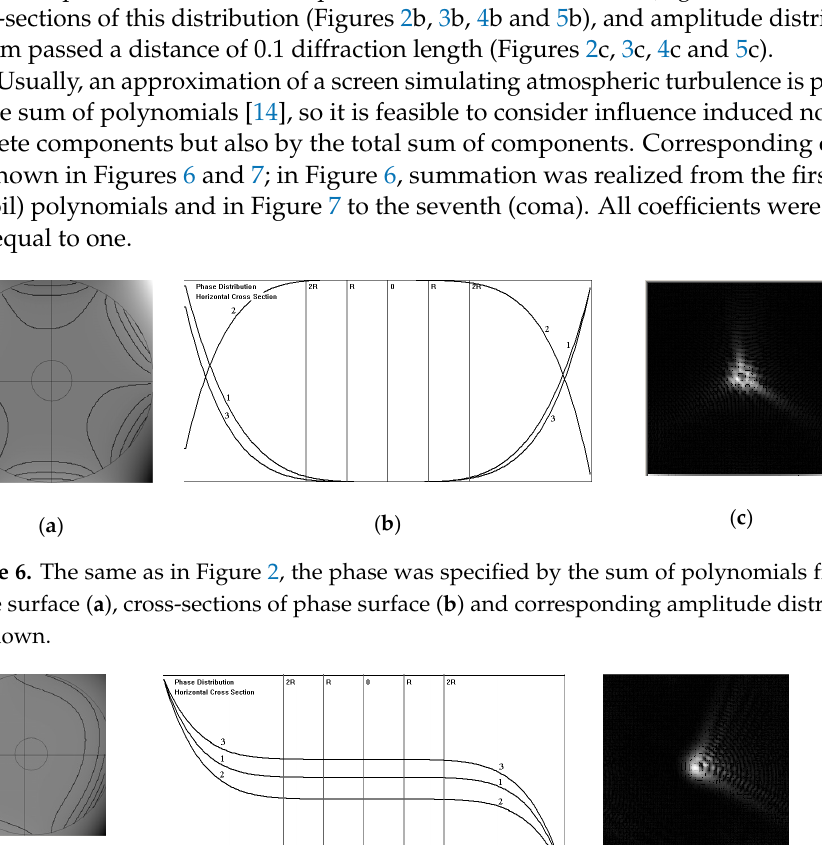
Figure 5. The same as in Figure 2, the phase was specified by polynomial No. 20. Phase surface ( a ), cross-sections of phase surface ( b ) and corresponding amplitude distribution ( c ) are shown.